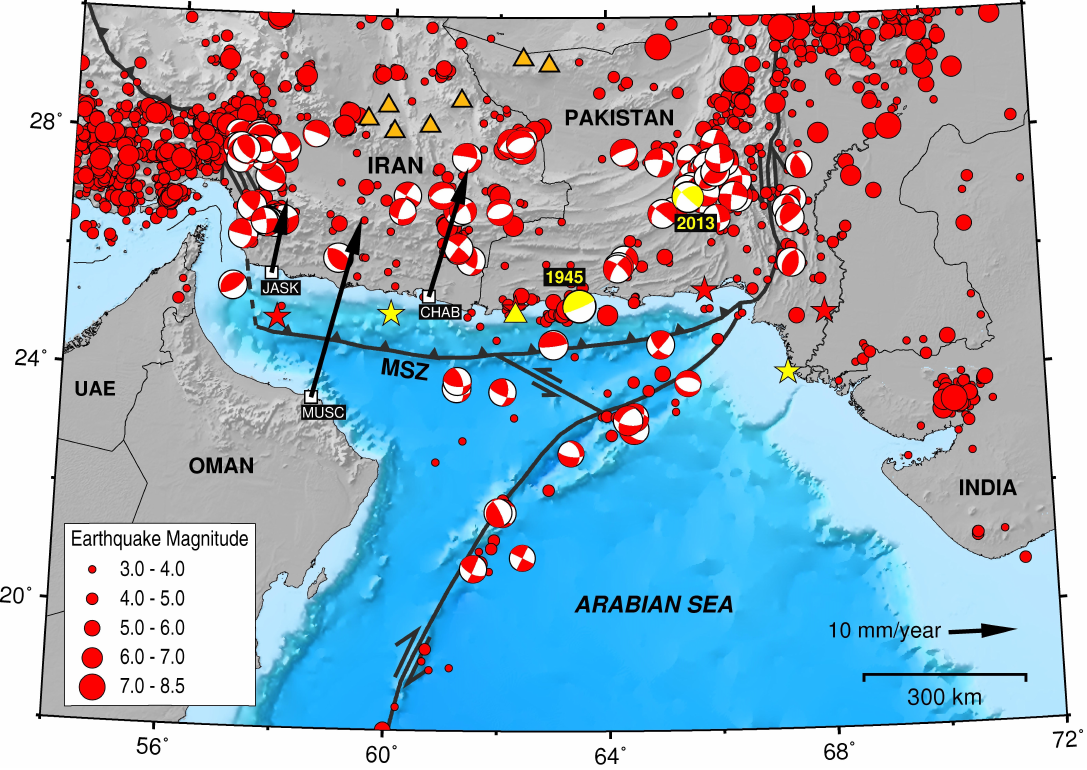
Figure 1. Seismicity of the Makran subduction zone (MSZ). Circles represent earthquakes from 1900 to 2019 from the ISC Catalog. Stars are historical earthquakes (pre-1900) from Heidarzadeh et al. [8]. Orange and yellow triangles represent volcanoes. Tsunamigenic events are illustrated by yellow color. Focal mechanisms are from the Global CMT Catalog. Dashed and solid black lines show the plate boundaries. Black arrows display estimated GPS horizontal velocities for JASK, CHAB, MUSC sites from Vernant et al.